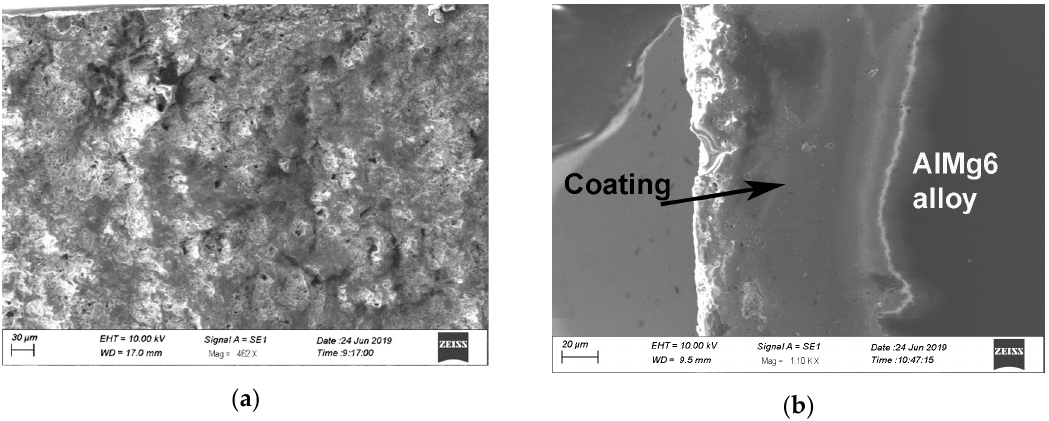
Figure 6. SEM image of the surface ( a ) and cross-section ( b ) of the sample with coating after stress corrosion tests.